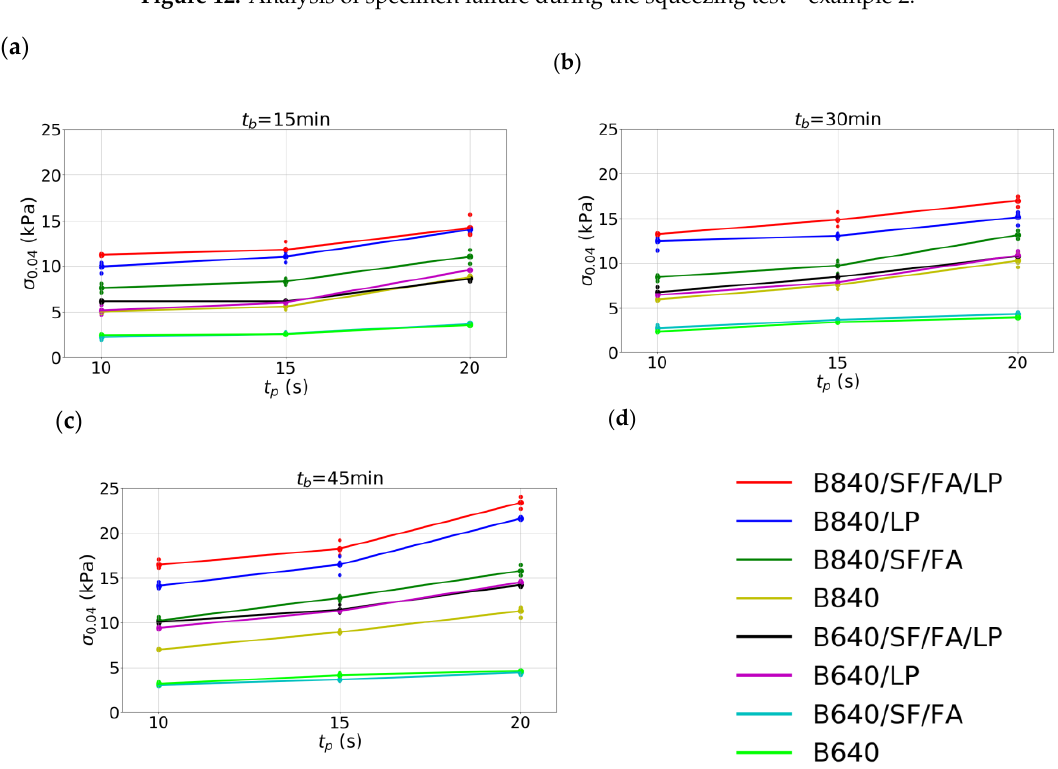
Figure 13. Comparison of the results of the squeezing test. ( a ) t b = 15 min; ( b ) t b = 30 min; ( c ) t b = 45 min; ( d )